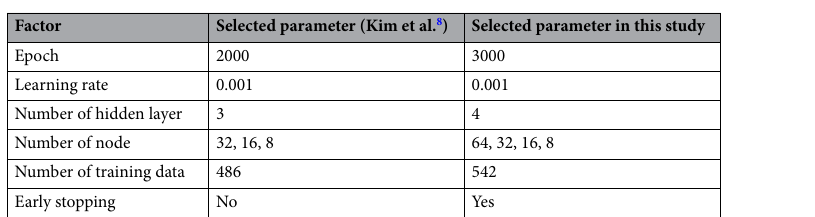
Table 2. Selected key parameters.